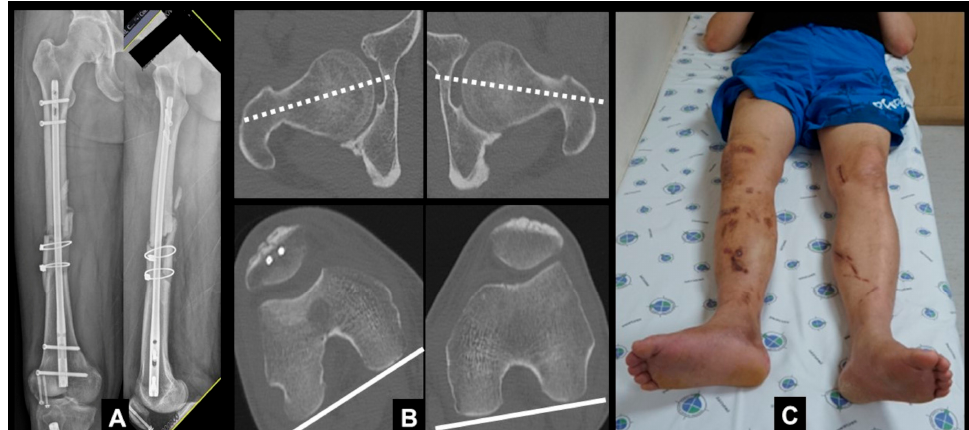
Figure 1. ( A ) Preoperative anteroposterior and lateral radiographs showing nonunion after retrograde nailing; ( B ) CT scan showing an evident difference in the femoral torsional angle between the affected and unaffected sides; ( C ) externally rotated foot on the right side indicating retroversion of the femur.